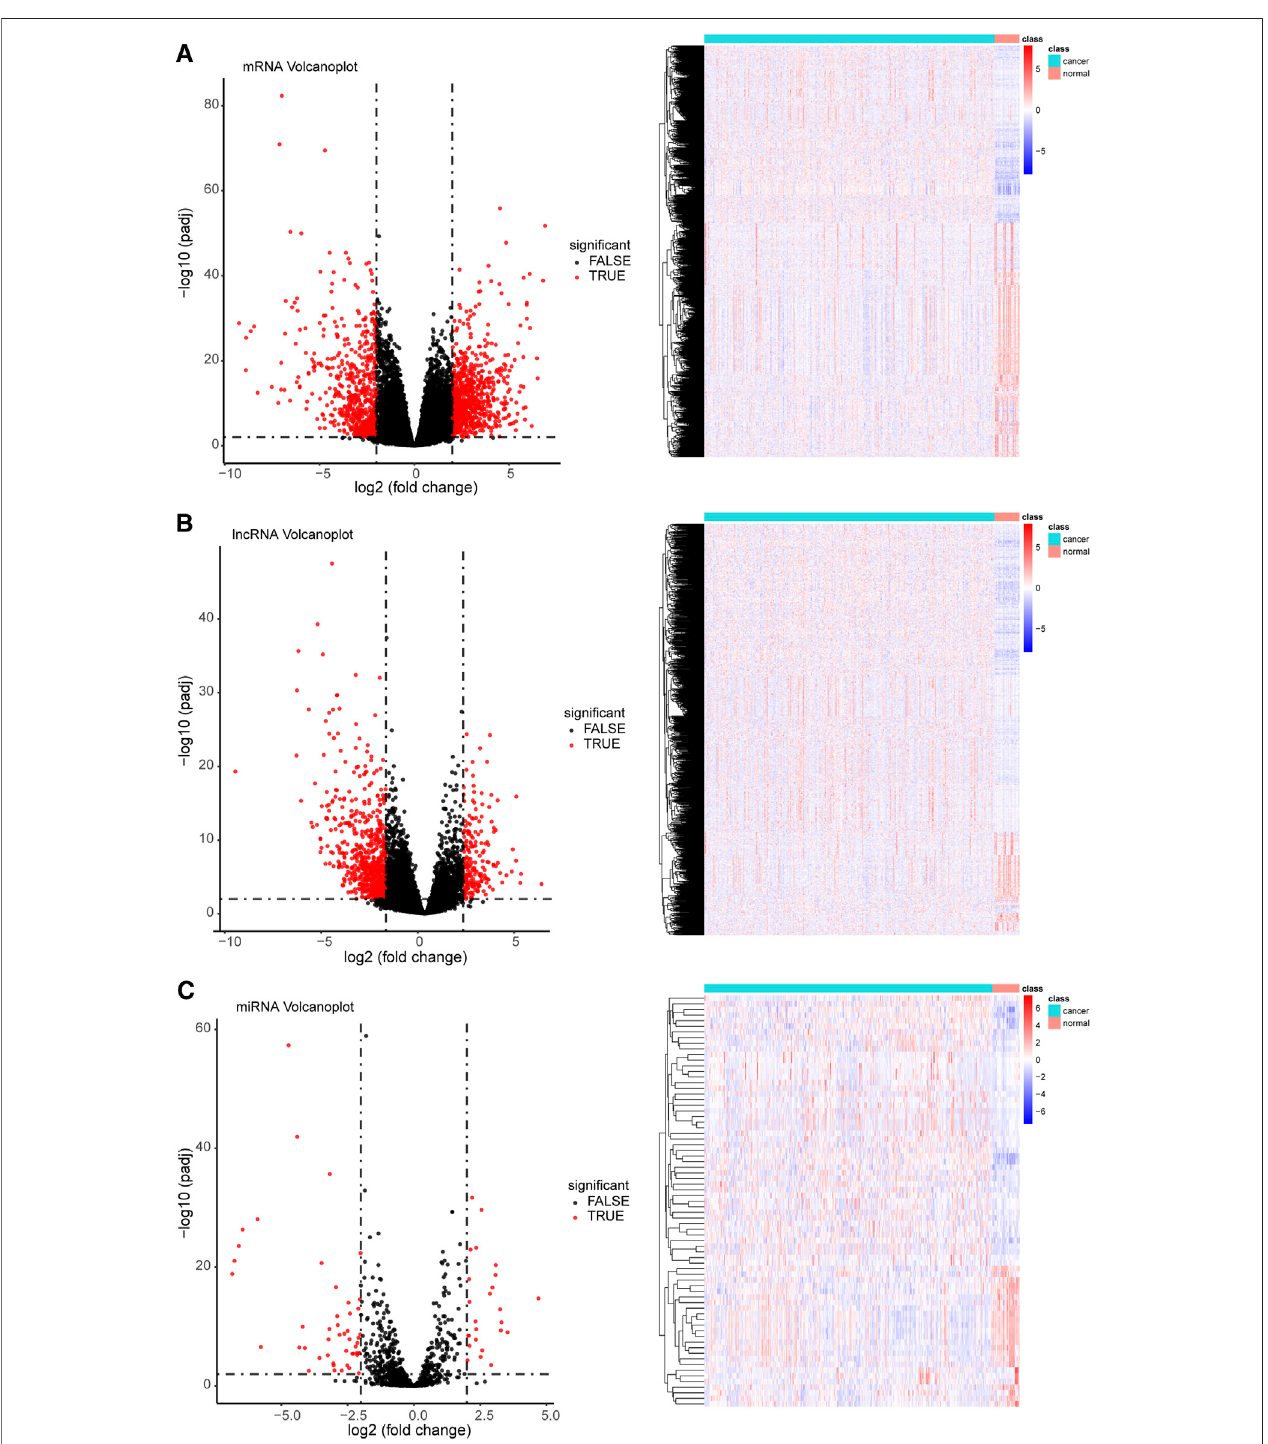
FIGURE 2 | Coexpression pro fi le of differentially expressed target genes (volcano plots and heatmaps) among cancer and normal tissue samples. (A) A total of 1,464 differentially expressed mRNAs (826 upregulated and 638 downregulated), (B) 910 differentially expressed lncRNAs (206 upregulated and 704 downregulated), and (C) 73differentiallyexpressedmiRNAs(25upregulatedand48downregulated)wereidenti fi ed(thresholdsetat|log(FoldChange) > 2|andwithafalsediscoveryrate < 0.01). For heatmaps, the colors red and blue indicate high and low relative expression, respectively. For volcano plots, red color on the right and left indicate upregulated and downregulated genes, respectively.